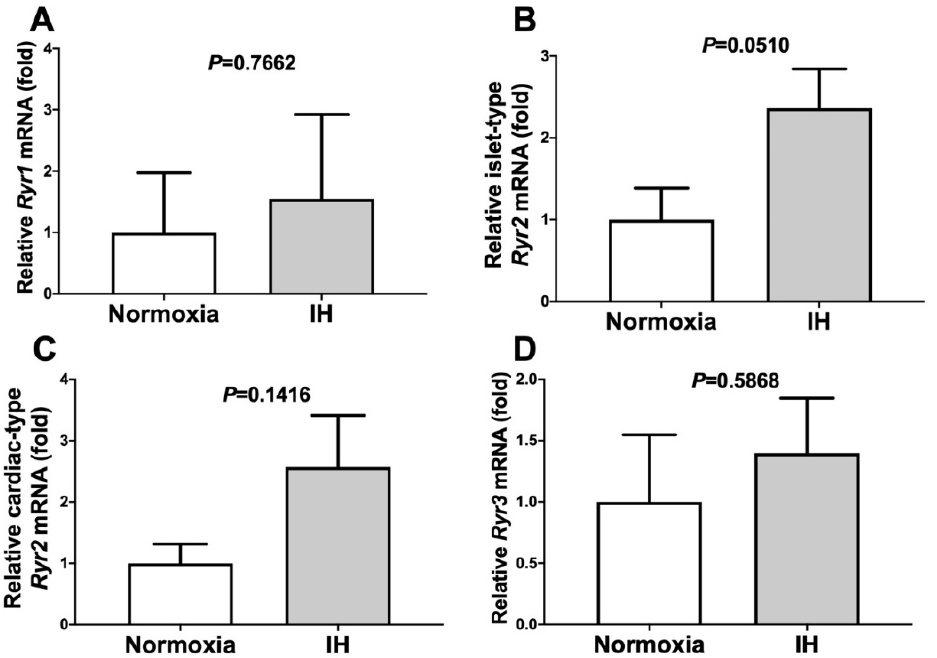
Figure 7. The mRNA levels of Ryr1 ( A ), islet-type Ryr2 ( B ), cardiac-type Ryr2 ( C ), and Ryr3 ( D ) in the As4.1 JG cells subjected to normoxia or IH for 24 h. In all cases, the mRNA levels were not elevated by IH ( P = 0.7662, P = 0.0510, P = 0.1416, and P = 0.5868 in the Ryr1 , islet-type Ryr2 , cardiac-type Ryr2 ,